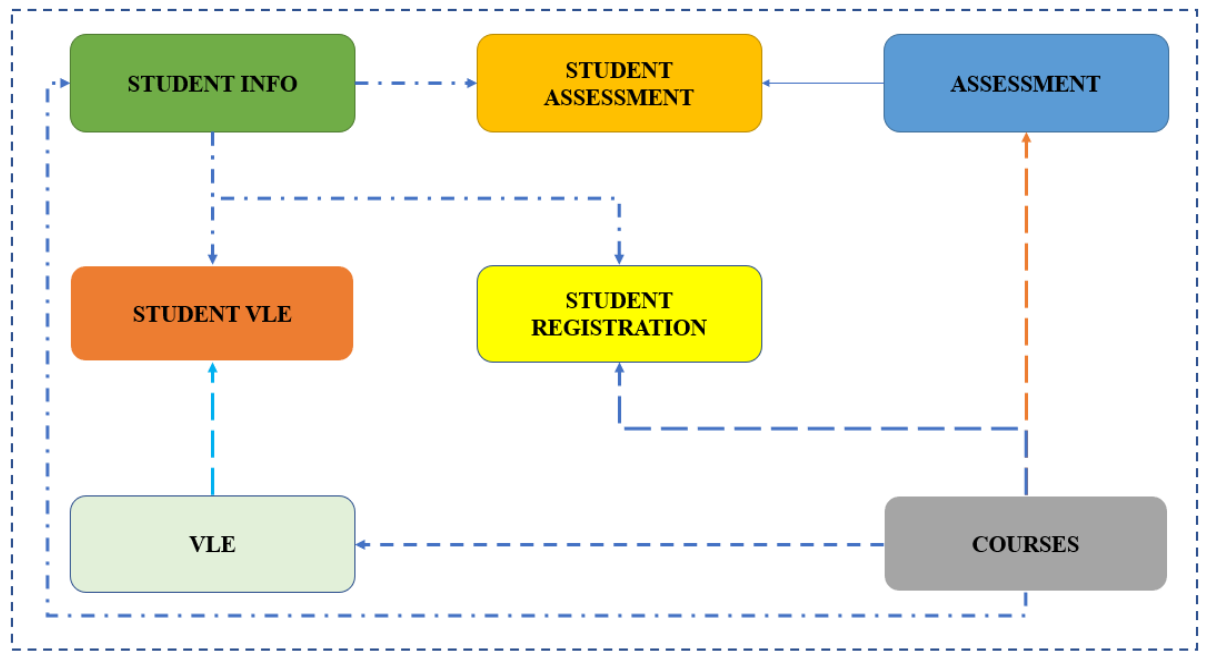
Figure 3. OULAD framework.